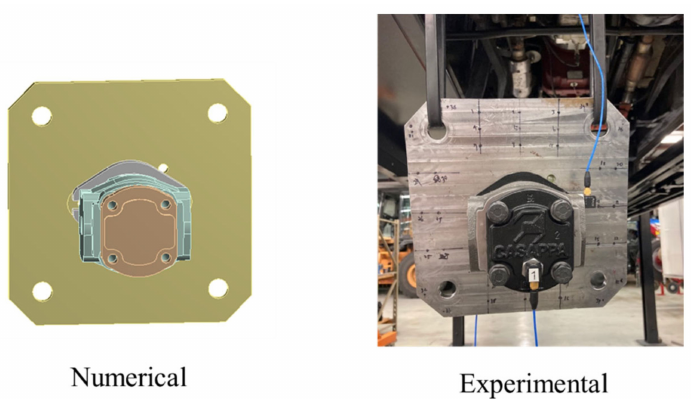
Figure 11. Numerical and experimental modal analysis setup for the assembly of the mounting plate and pump.